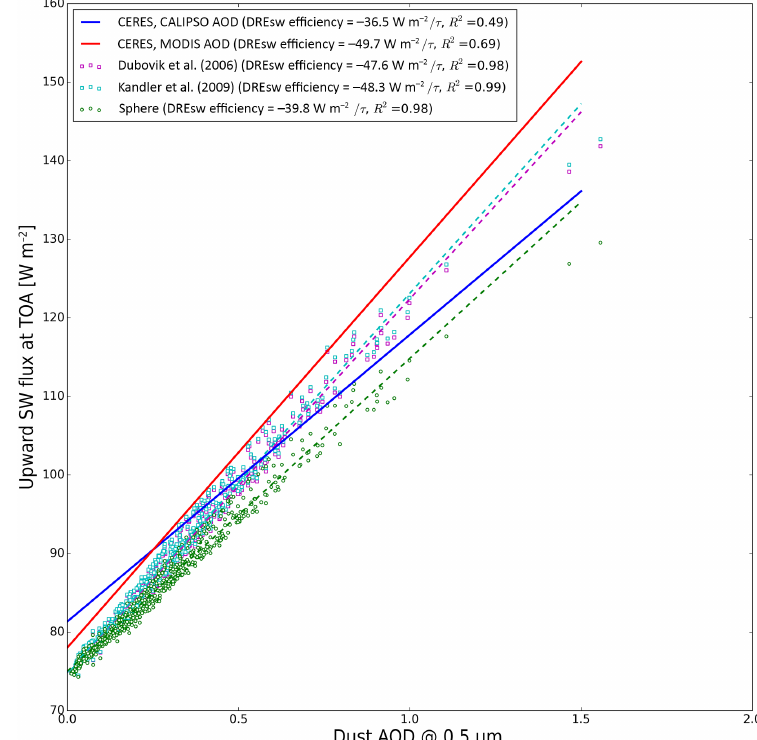
Figure 10. The radiative transfer simulations are shown for the selected cases based on the three dust shape models. Table 5. Diurnally mean DRE SW and DRE SW efficiency at TOA and the surface. PSD Refractive index Shape TOA DRE SW efficiency TOA DRE SW Fennec-SAL Colarco-SW Dubovik − 28 − 9 . 9 − 82 . 1 − 26 . 0 AERONET OPAC-SW Dubovik − 29 . 4 − 10 . 3 − 85 . 7 − 27 . 2 Fennec-SAL Colarco-SW Sphere − 22 . 8 − 8 . 2 − 89 . 6 − 28 .